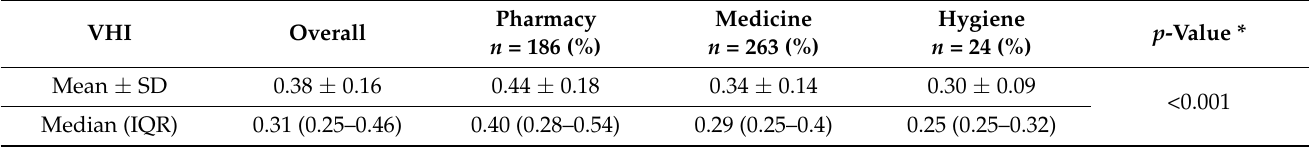
Table 3. Vaccine Hesitancy Index.